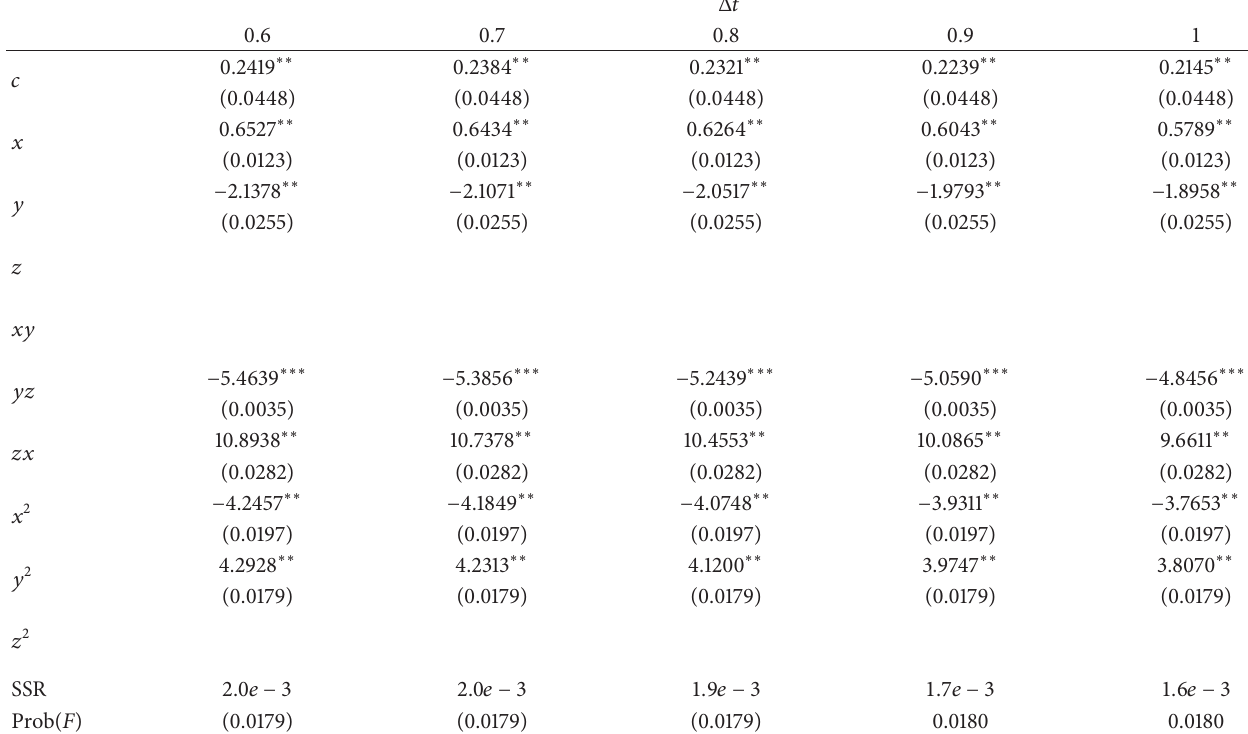
Table 3: The second equation in (9) under the several time steps of